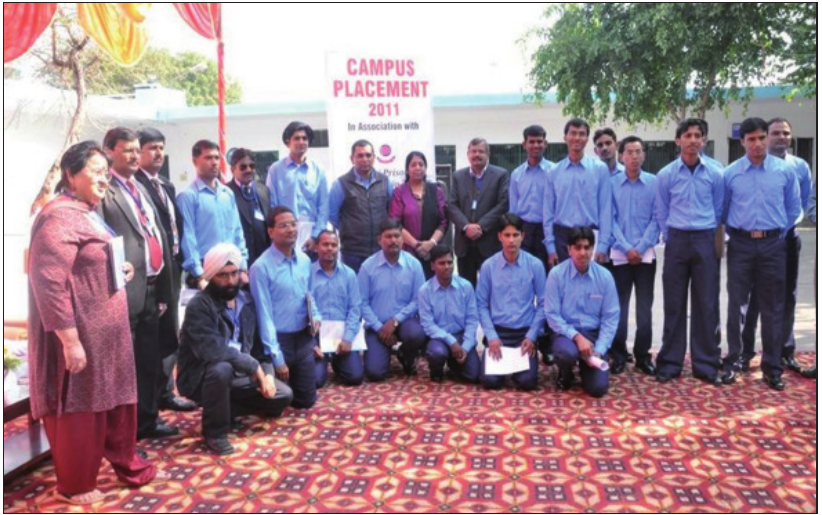
Figure 6 Job placement for former inmates Source: Photo courtesy of Tihar Central